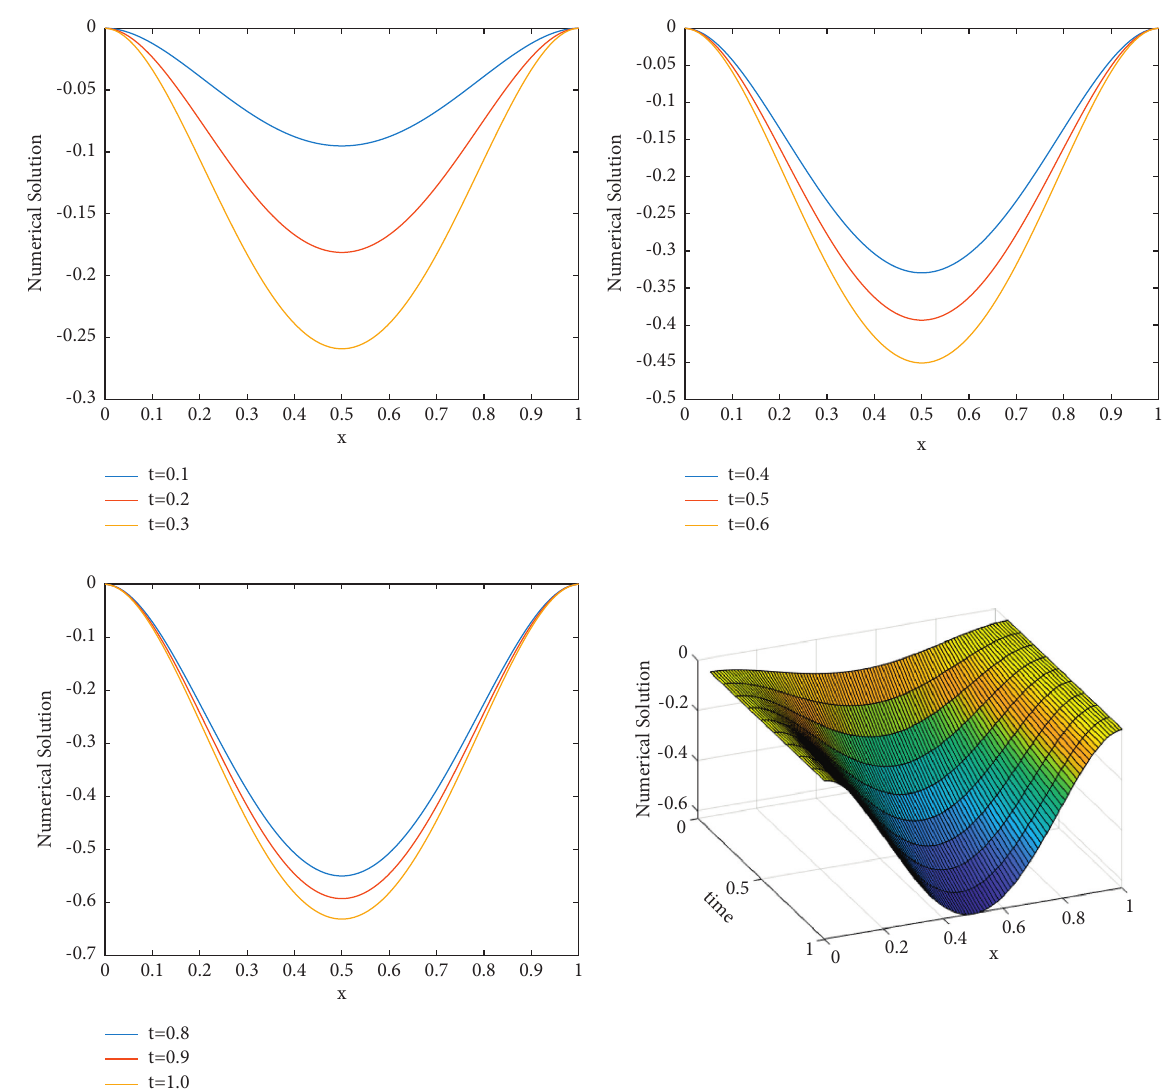
Figure 4: Solution behavior of the mode at different time with parameter ε � 10 − 4 , μ � 10 − 10 and M �